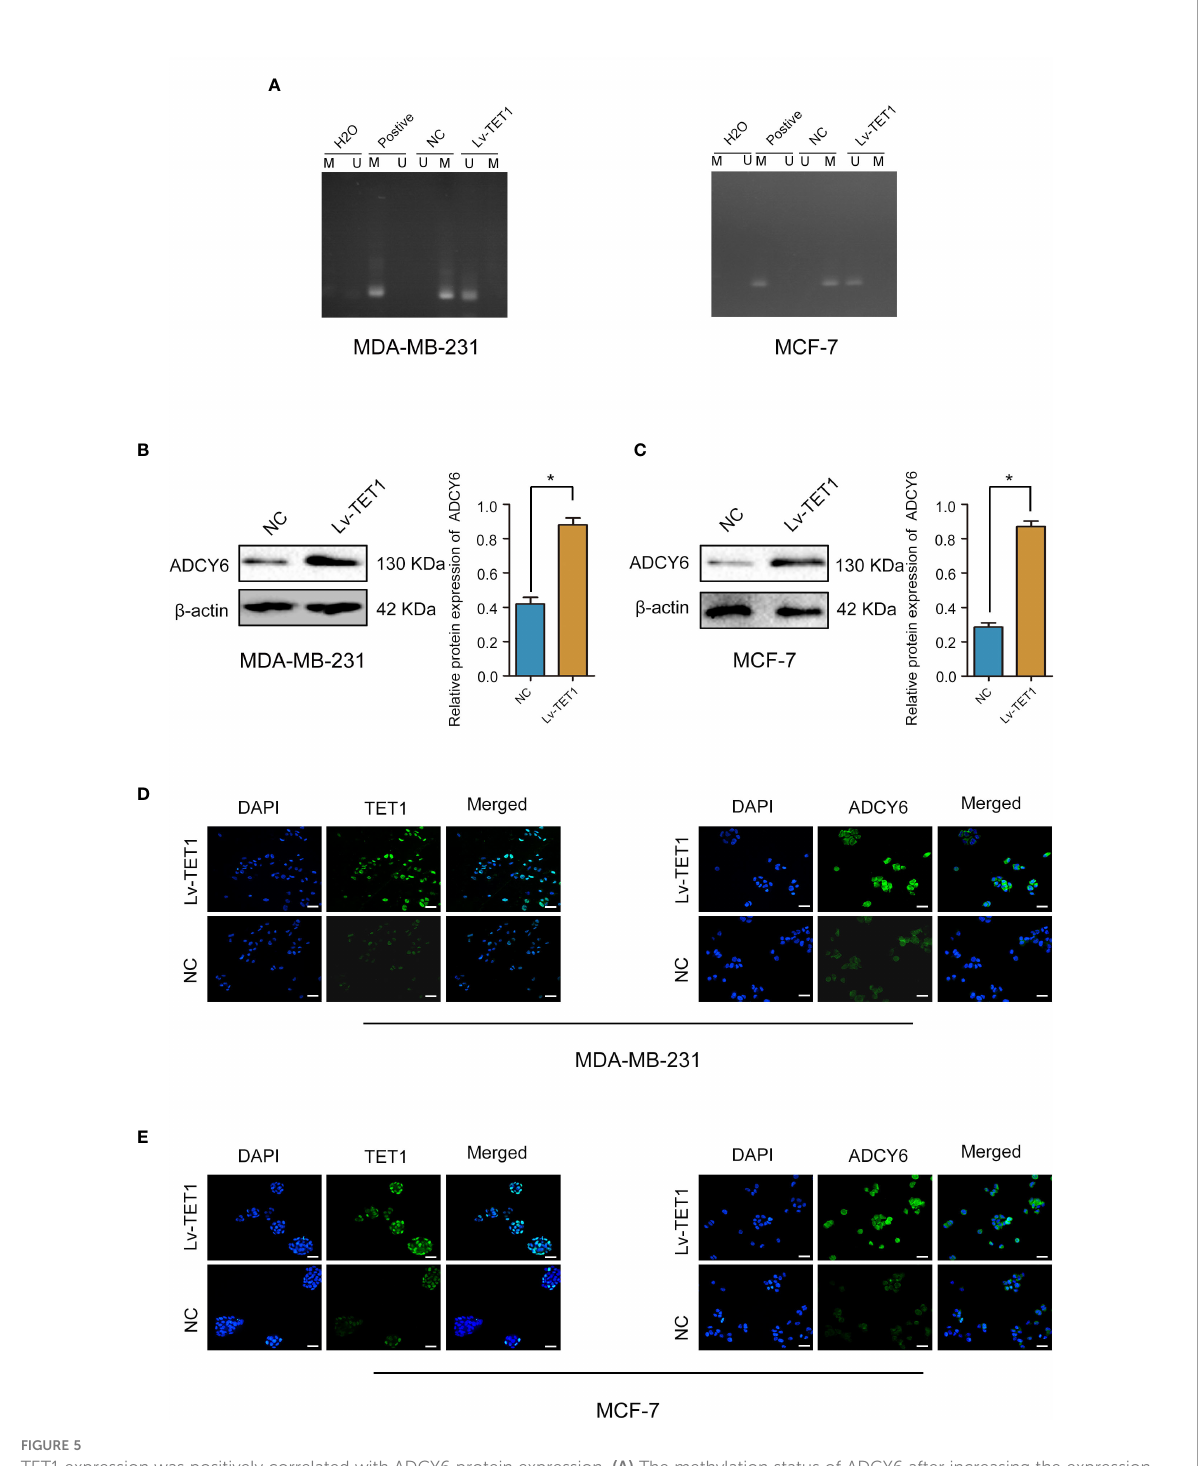
FIGURE 5 TET1 expression was positively correlated with ADCY6 protein expression. (A) The methylation status of ADCY6 after increasing the expression of TET1 in breast cancer cell lines. (B) The protein expression of ADCY6 after increasing the expression of TET1 was detected by western blot in MDA-MB-231 cells. *p < 0.05 versus controls. (C) The protein expression of ADCY6 after increasing the expression of TET1 was detected by western blot in MCF-7 cells. *p < 0.05 versus controls. (D) The protein expression of TET1 and ADCY6 after increasing the expression of TET1 was detected by immuno fl uorescence in MDA-MB-231 cells. Scale bars, 50 µm. (E) The protein expression of TET1 and ADCY6 after increasing the expression of TET1 were detected by immuno fl uorescence in MCF-7 cells. Scale bars, 50